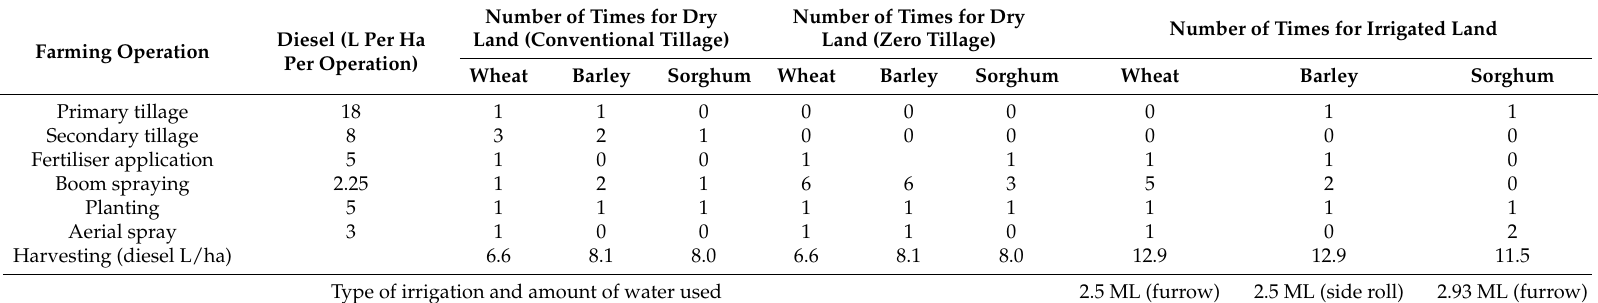
Number of Times for Dry Land (Zero Tillage)